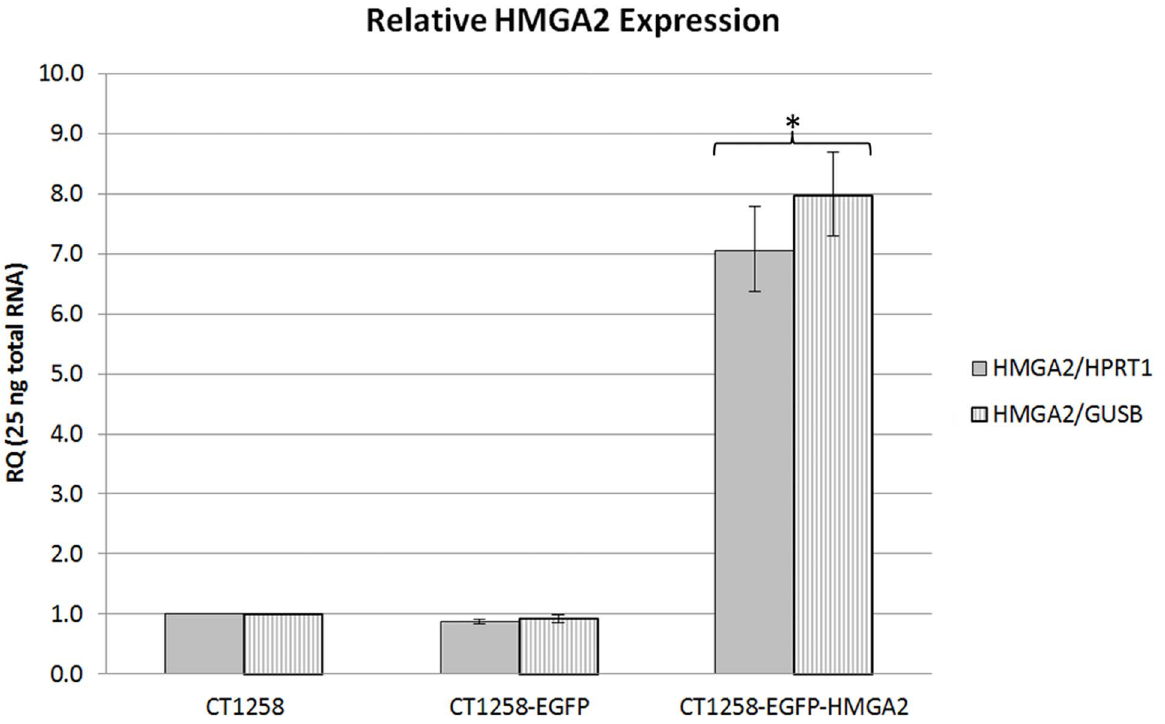
Figure 3. HMGA2 real-time PCR analyses. Relative HMGA2/HPRT1 and HMGA2/GUSB expression in native CT1258, CT1258-EGFP and CT1258- HMGA2-EGFP cells. Error bars are standard deviations. *p # 0.05 indicates a statistical significant expression deregulation of HMGA2 in CT1258- HMGA2-EGFP cells when compared to native CT1258.